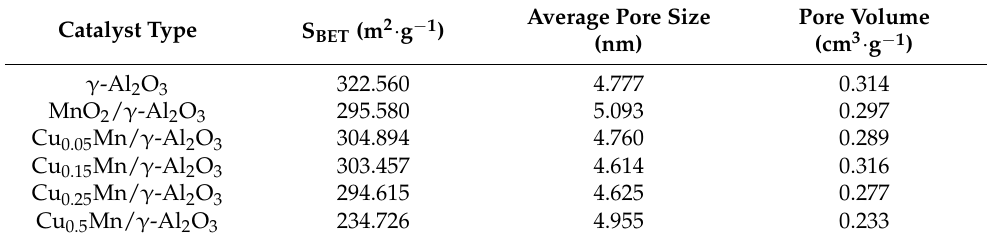
Table 1. Comparison of specific surface area, average pore diameter, and pore volume of different catalysts.